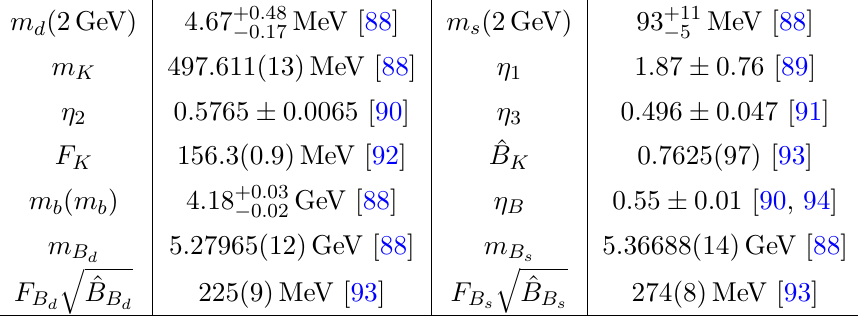
Table 2 . The input parameters relevant to the analyses on flavor physics. We use the central value of those parameters in the numerical analysis.